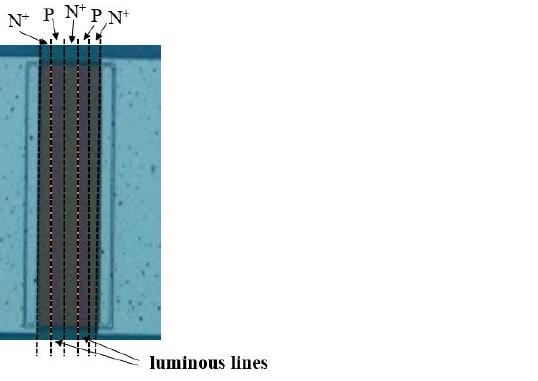
Figure 5. Micrograph of the light source under experimental conditions.